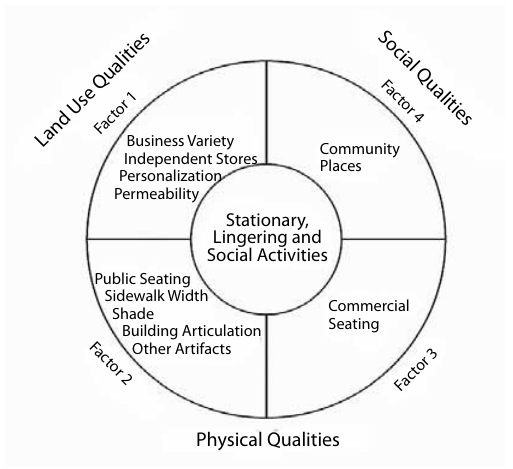
fig. 3. Qualities of commercial streets that promote stationary activities and interactions (Mehta